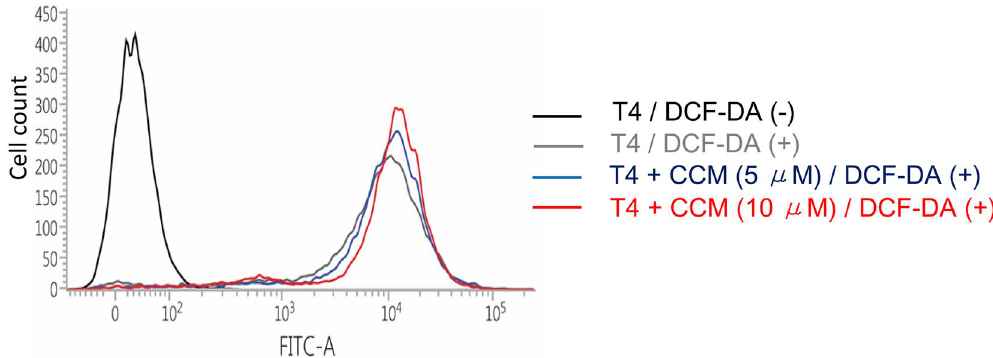
Figure 2. Curcumin does not increase endogenous ROS. Mouse cortical cells were treated with DMSO, 5 μM or 10 μM curcumin (CCM) for 6 h followed by treatment with DMSO (DCF-DA (−)) or 10 μM DCF-DA (DCF-DA (+)) in DMEM without serum for 30 min. The fluorescence signal was detected at the FITC channel on a FACS Instrument.